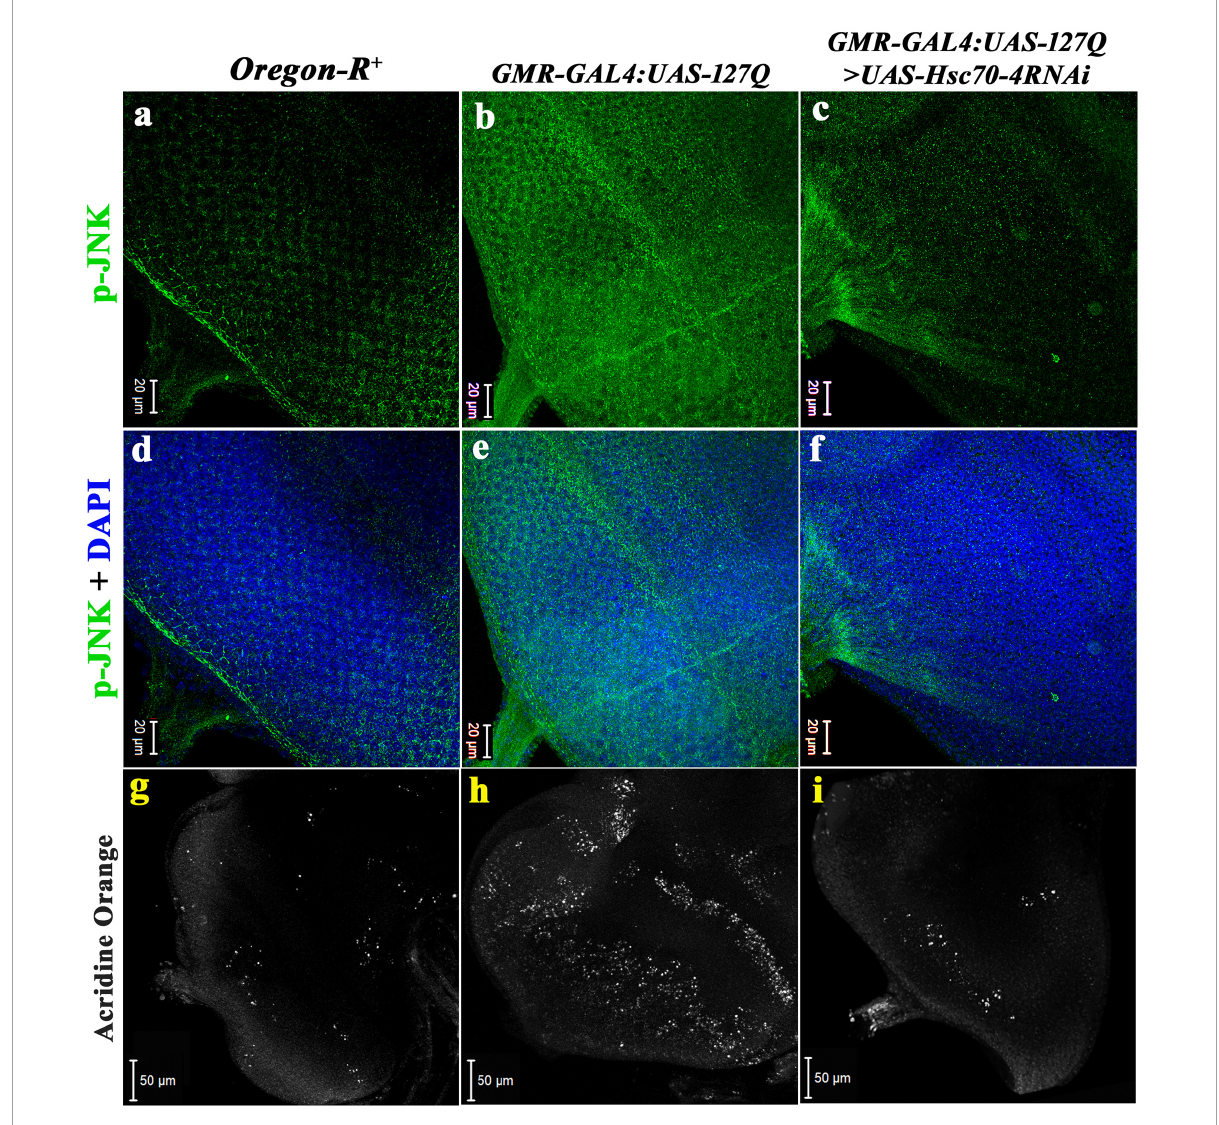
FIGURE6 Downregulation of hsc70-4 reduces the elevated p-JNK level in polyQ- overexpressed background, thus rescuing the cell death in the diseased eye disc. (a) The eye disc of Oregon-R + shows the typical expression pattern of p-JNK (in green), which drastically elevates in panel (b) GMR-GAL4:UAS-127Q, and (c) downregulating hsc70-4 in the polyQ- overexpressed condition reduces the hyperactivated p-JNK. Panels (d–f) show p-JNK staining merged with DAPI in the eye disc of Oregon-R + , GMR-GAL4:UAS-127Q, and GMR-GAL4:UAS-127Q > UAS-Hsc70-4RNAi, respectively (scale bar 20 µ m). White puncta in the images (g–i) are acridine orange stained dead cells in the eye disc of third instars of Oregon-R + , GMR-GAL4:UAS-127Q , and GMR-GAL4:UAS-127Q > UAS-Hsc70-4RNAi, respectively, (scale bar 50 µ